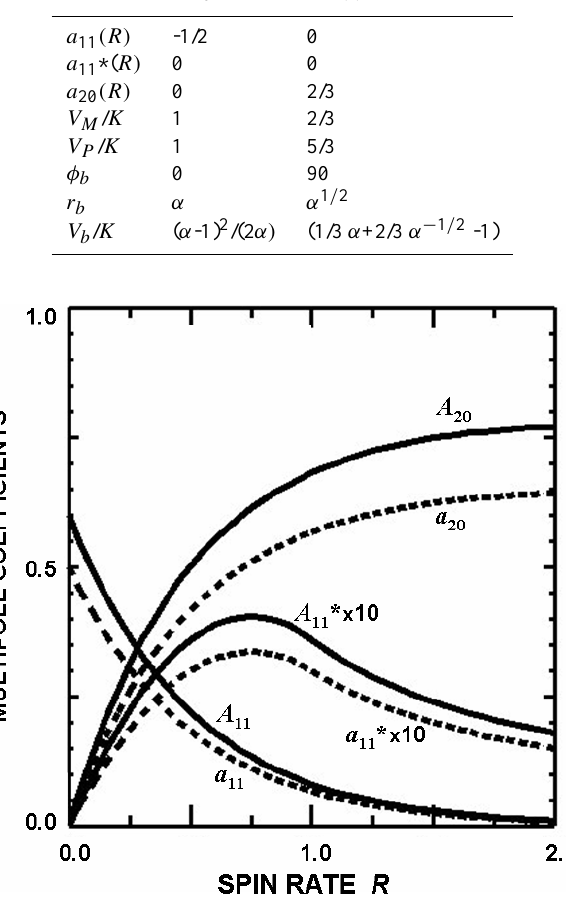
Fig. 3. Representative plots showing the R dependence of the abso- lute value of the multipole coefficients. The solid lines are for α =1.2 and the dashed lines for alpha=1.0. The A ∗ terms are multiplied 11 by 10 for clarity. The differential charging voltages, D and d , are obtained by multiplying A 11 and A ∗ by − 2 K 11